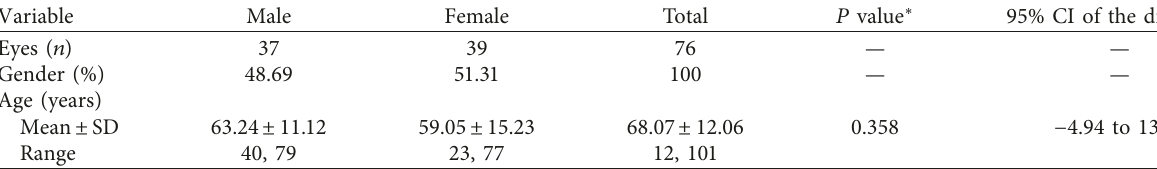
Table 1: Demographic data of included POAG patients.